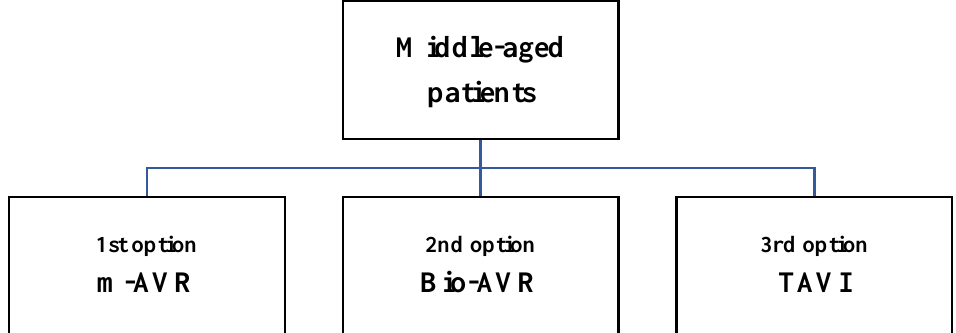
Figure 2. Priority of aortic valve substitutes for middle-aged patients. Table 4. Decision Making Algorithm. m-AVR for middle-aged patients.